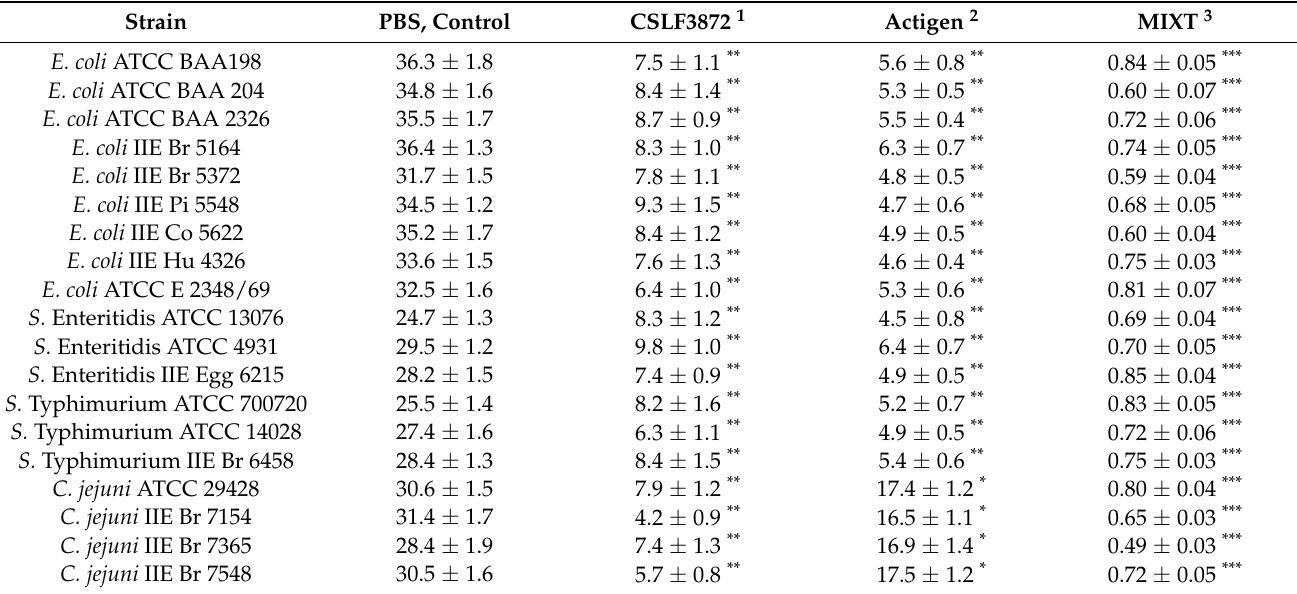
Table 8. Synergism of CSLF3872 and Actigen prebiotic in inhibiting the adhesion of proteobacteria pathogens ( E. coli , Salmonella , Campylobacter ) to Caco-2 cells.